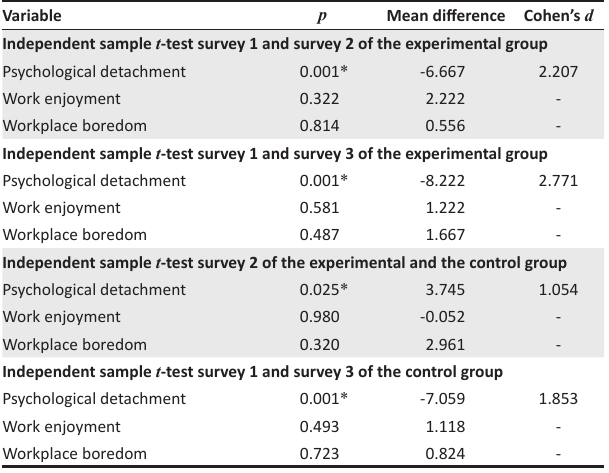
TABLE 5: Independent sample t-test results.